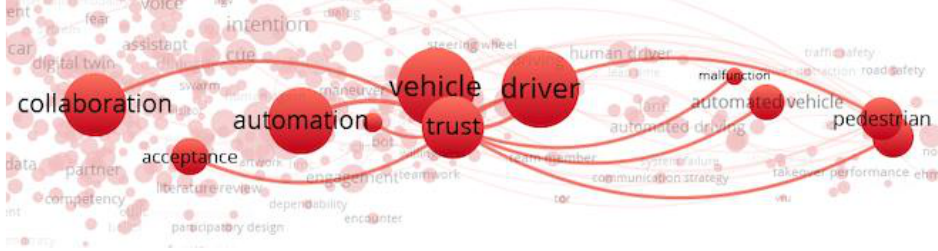
Figure 12. Trust dependency.